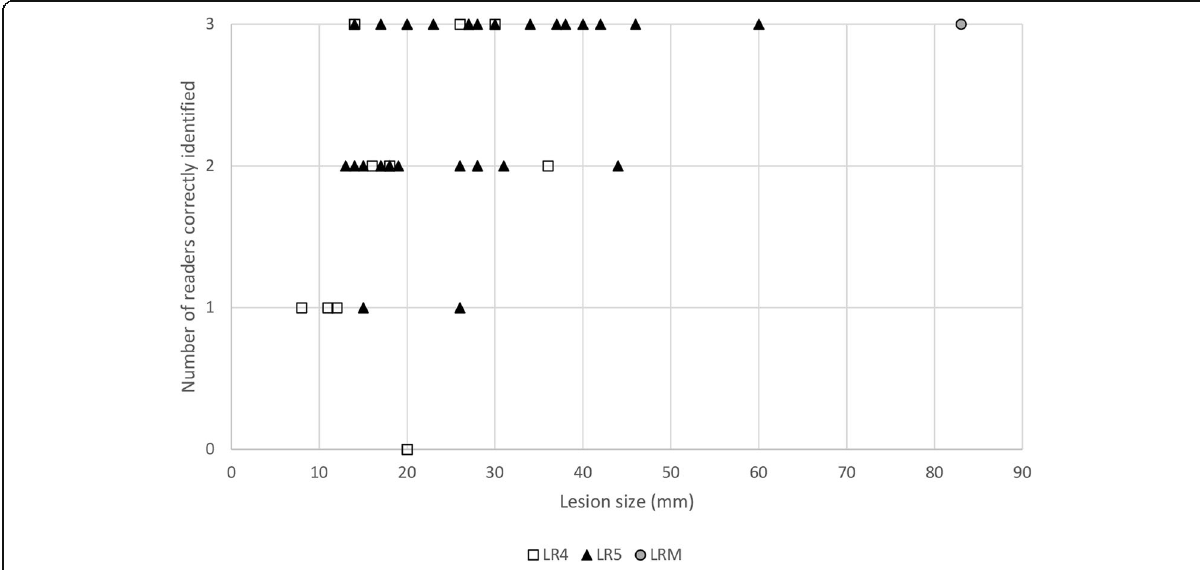
Fig. 5 Lesion size and Liver Imaging Reporting and Data System (LI-RADS) category versus detection by readers. LR